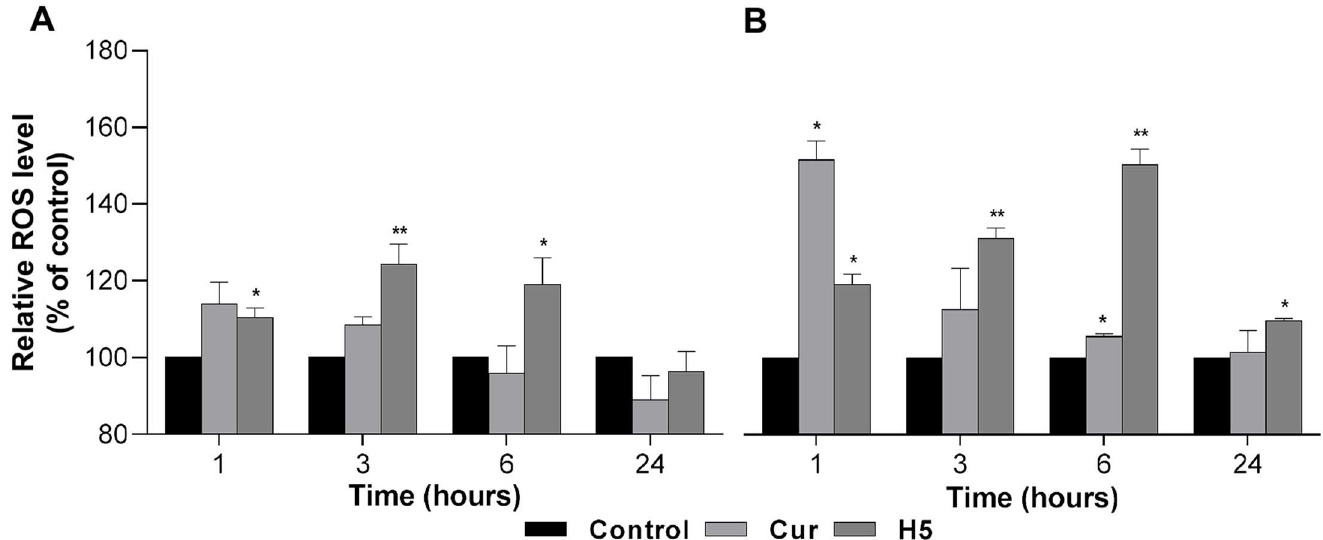
Fig 6. Effect of Cur treatment on ROS generation. IntracellularROS concentration was determinedby treating AsPC-1 (A) and BxPC-3 (B) cells with free Curcumin and Curcuminin the H5 formulation,with Cur used at the effective IC50 concentration at time intervals of 1, 3, 6 and 24 hours, respectively. The data are shown as the mean ± SD of three independentreplicates. Statistical analysisby unpairedstudent t -test: * p < 0.05; ** p < 0.001.